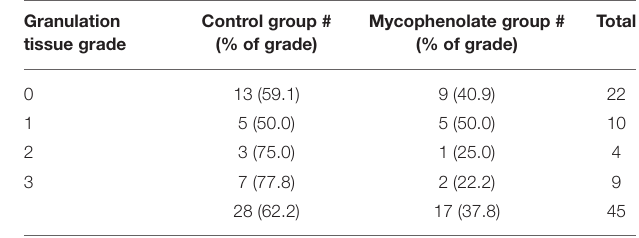
TABLE 4 | Presence and severity of granulation tissue at 1 month ± 2 week time point. Granulation tissue grade